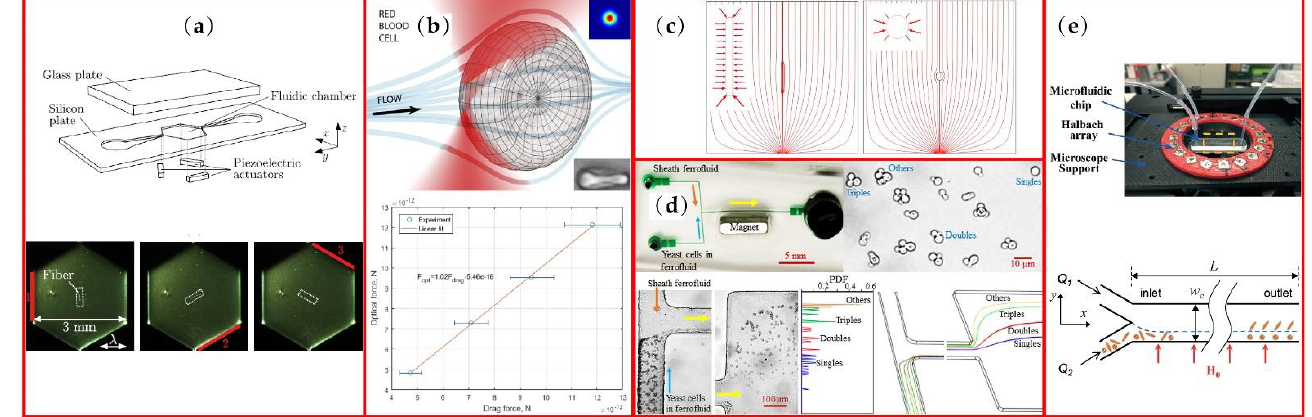
Figure 3. Active manipulation methods of non-spherical particles: ( a ) sketch of micro device for fiber rotation and images of fiber rotation process; ( b ) RBC trapped by single beam and the optical force estimated from the drag force; ( c ) electric field stream-line and DEP force arrows around rod and spherical particles; ( d ) T-shape microchannel under uniform magnetic field, yeast cells sample and experimental results of magnetic fractionation; ( e ) microfluidic chip in a uniform magnetic field and schematic of separation in the microchannel. Figure ( a ) is reprinted with permission from [48], Copyright 2015 Springer Nature. Figure ( b ) is reprinted with permission from [52], Copyright 2018 Springer Nature. Figure ( c ) is reprinted with permission from [37], Copyright 2015 Springer Nature. Figure ( d ) is reprinted with permission from [63], Copyright 2017 AIP publishing. Figure ( e ) is reprinted with permission from [65], Copyright 2017 RSC publishing.